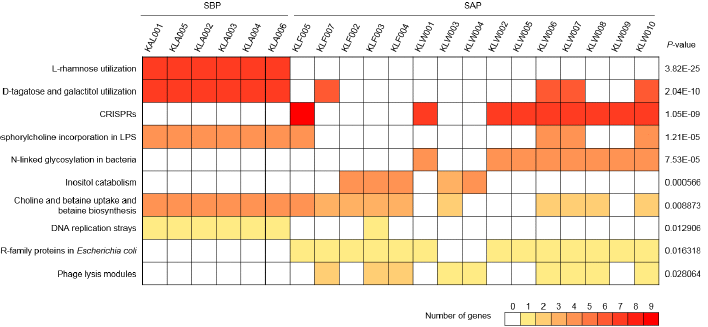
Fig 3. Comparison of RAST subsystems of the isolated genomes. The genomeswere annotated and groupedby RAST with default optionsfor bacteria. The different colors show the number of genesthat incorporated in each subsystem (see color bar). Statistical analysiswas carried out using Fisher’s exact test betweenSBPs and SAPs, and the significantly different subsystems are shown in the figure (P < 0.05).